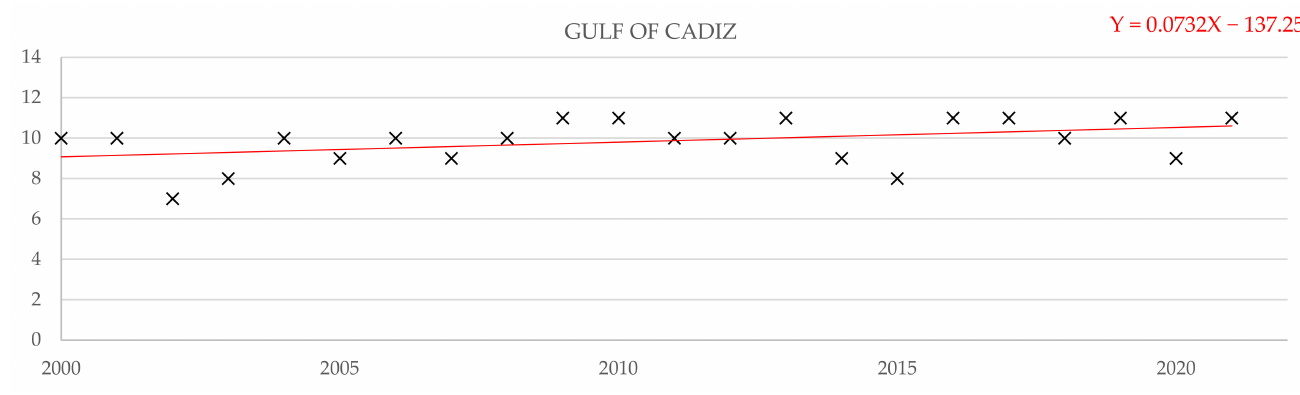
Figure 26. Number of times Hs has exceeded the threshold in Begur.